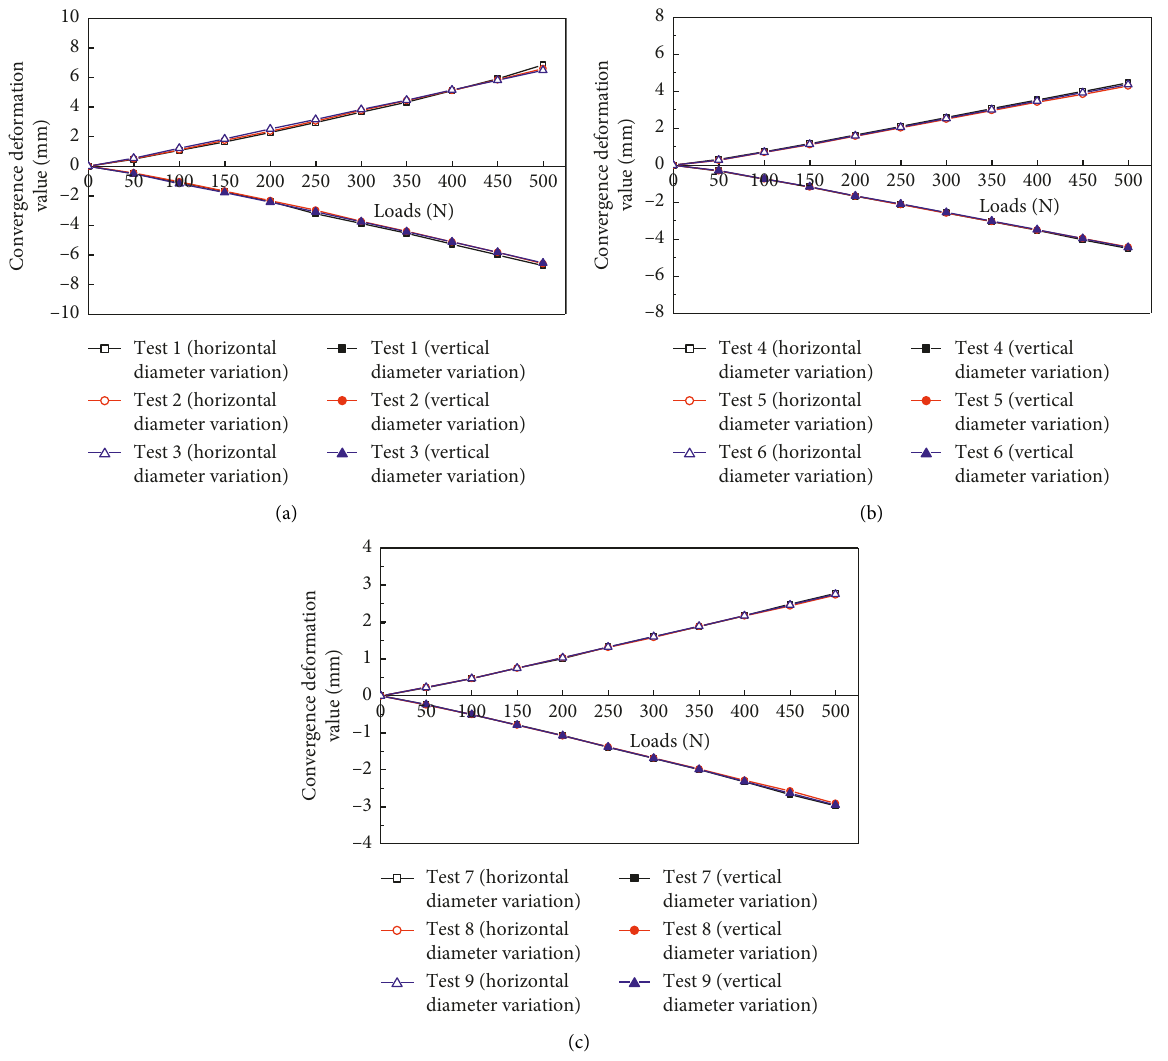
Figure 7: Variations in the vertical and horizontal diameters of the middle ring with increasing load for nine tests under the concentrated loading conditions. (a) Straight-jointed ring. (b) Stagger-jointed ring. (c) Uniform